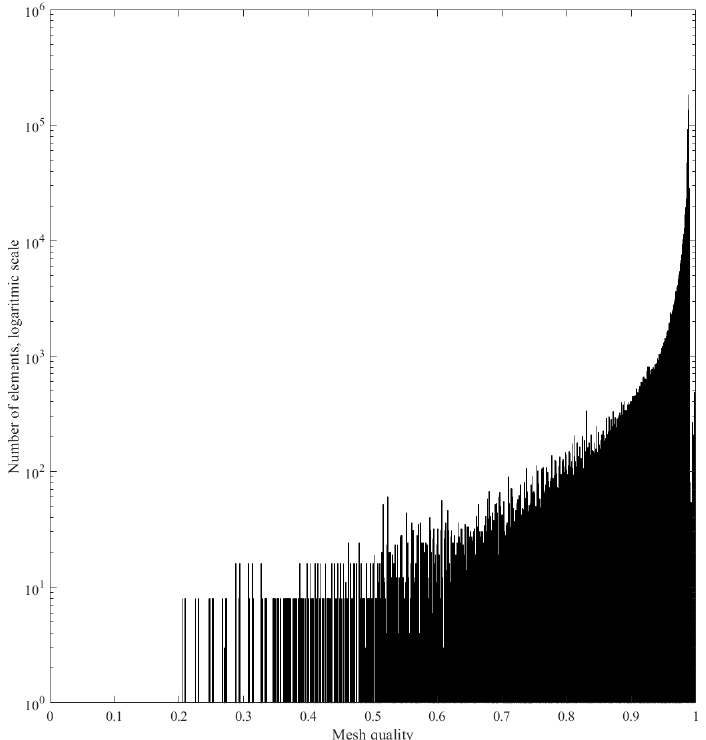
Figure 6. Picture showing the tetrahedral mesh on the transducer (highlighted in blue) and the quadratic mesh on the plate.